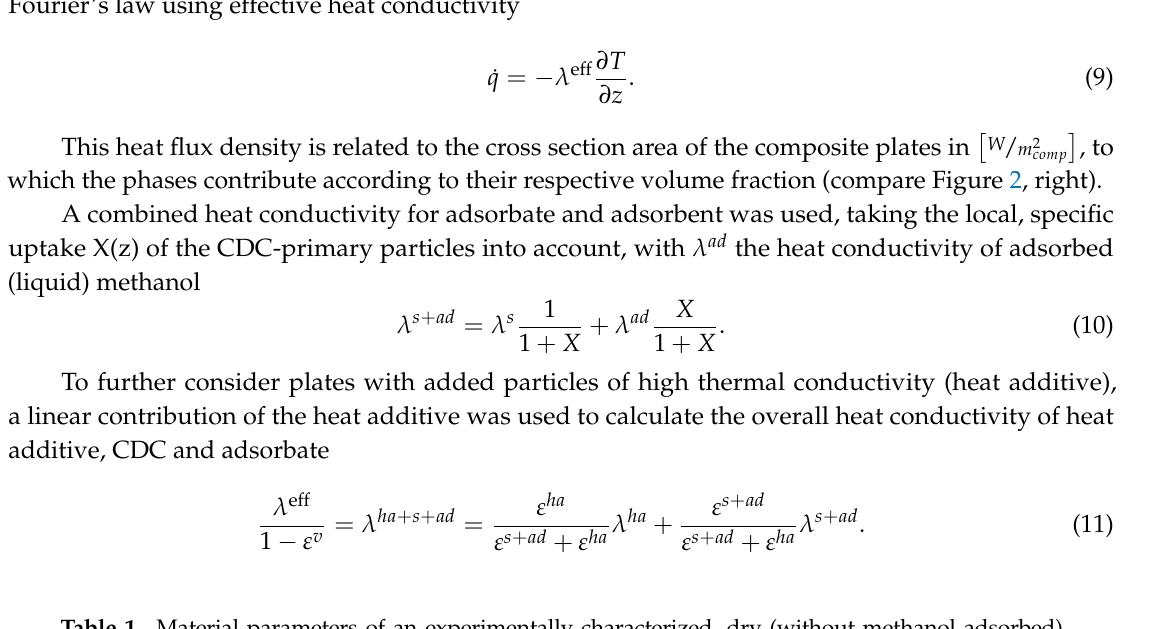
Table 1. Material parameters of an experimentally characterized, dry (without methanol adsorbed) CDC-plate with negligible binder content, without heat additive and physical properties of heat